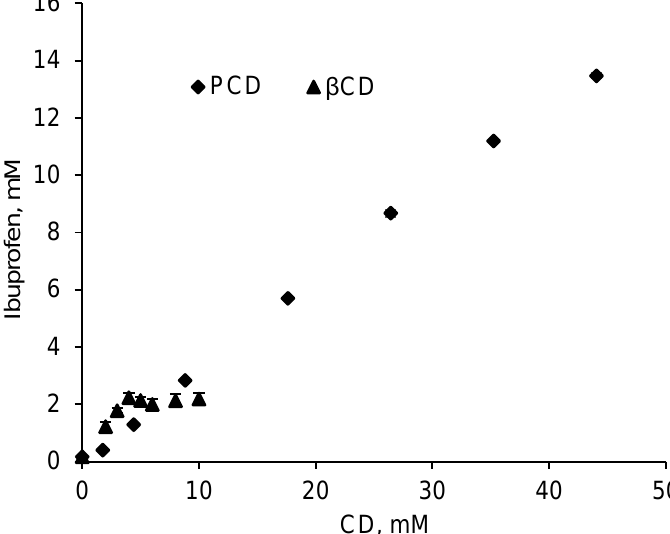
Figure 2. Solubility diagram of IBU with increasing concentrations of pristine βCD and polymerized βCD (PCD) in a pH = 2 buffer solution (KCl 0.2M and HCl 0.1M) at room temperature after 24 h of stirring (210 rpm).